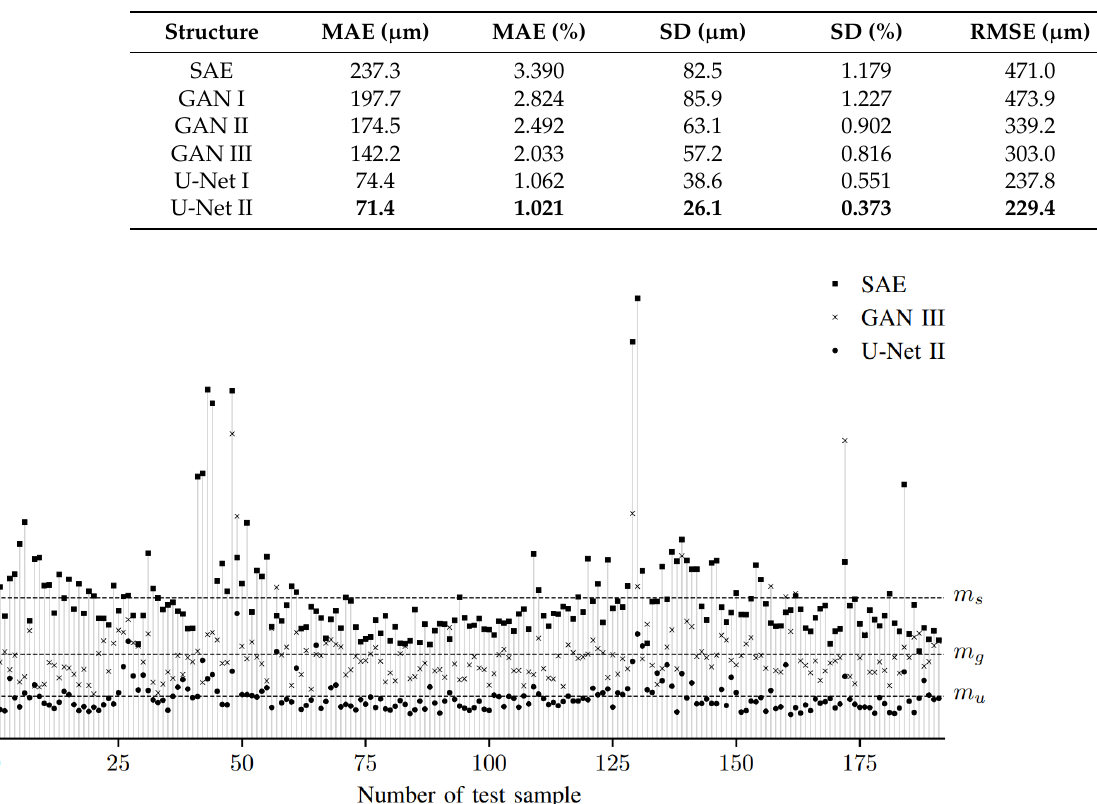
Table 5. Mean MAE and RMSE of the 3D reconstruction algorithms. In addition of the MAE, its standard deviation (SD) is calculated to indicate the dispersion in the test samples.